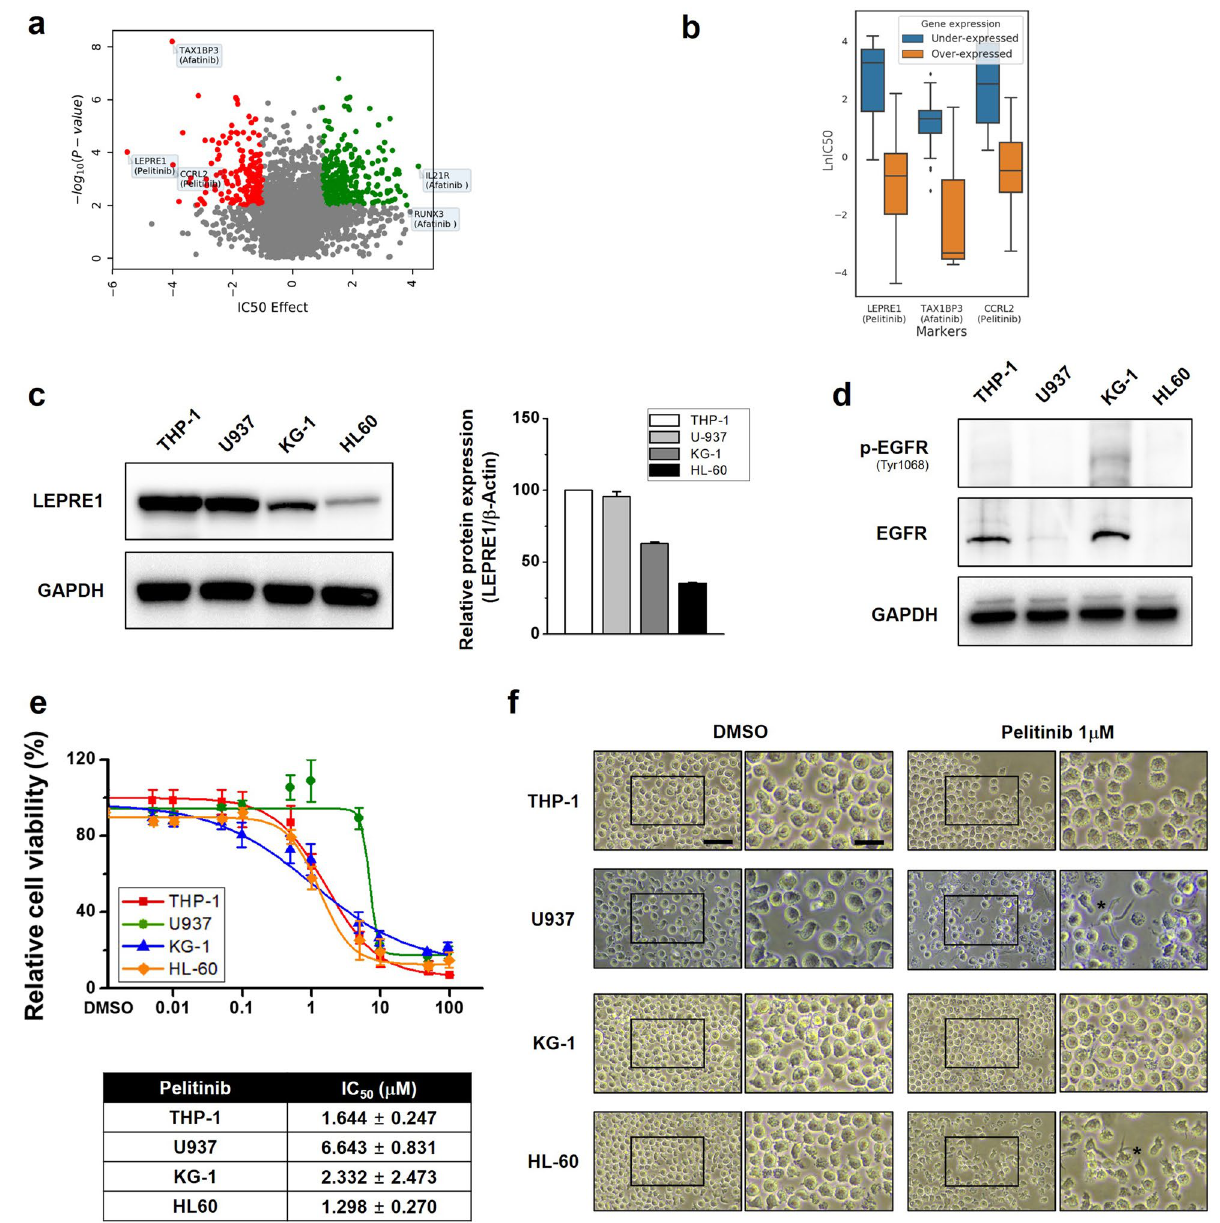
Figure 1. LEPRE1 in blood cancer cells is a potential biomarker for pelitinib treatment. (a ) Volcano plot showing the variation in IC 50 effect for the drugs and genes indicated. The significance (p-value) between drug responsiveness and the gene expression level was calculated using a t-test. ( b ) Box plots show the IC 50 values of the drugs according to gene expression levels of the samples. ( c ) Differential expression levels of LEPRE1 and pelitinib sensitivity in AML cell lines. LEPRE1 protein levels in AML cells were evaluated by immunoblotting using a LEPRE1-specific antibody. ( d ) Absence of EGFR expression in AML-derived U937 and HL60 cells determined by immunoblotting. ( e ) WST-1 proliferation assay with pelitinib. AML cells were treated with the indicated concentration of pelitinib for 72 h, and the WST-1 assay was used to assess cell viability. Data are shown as the mean ± SEM (n = 3). Red line: THP-1 cells, green line: U937 cells, blue line: KG-1 cells, orange line: HL60 cells. The IC 50 of each cell line is shown in the lower panel. ( f ) Effect of DMSO or pelitinib (1 μM) on cell morphology. The AML cell lines were treated with DMSO or pelitinib for 72 h. Undifferentiated cells and differentiated cells (asterisks) are shown in a selected enhanced micrograph on the right panel of each picture. The asterisks (*) indicates differentiated cell morphology. Scale bar, 100 μm (low magnification), 50 μm (high